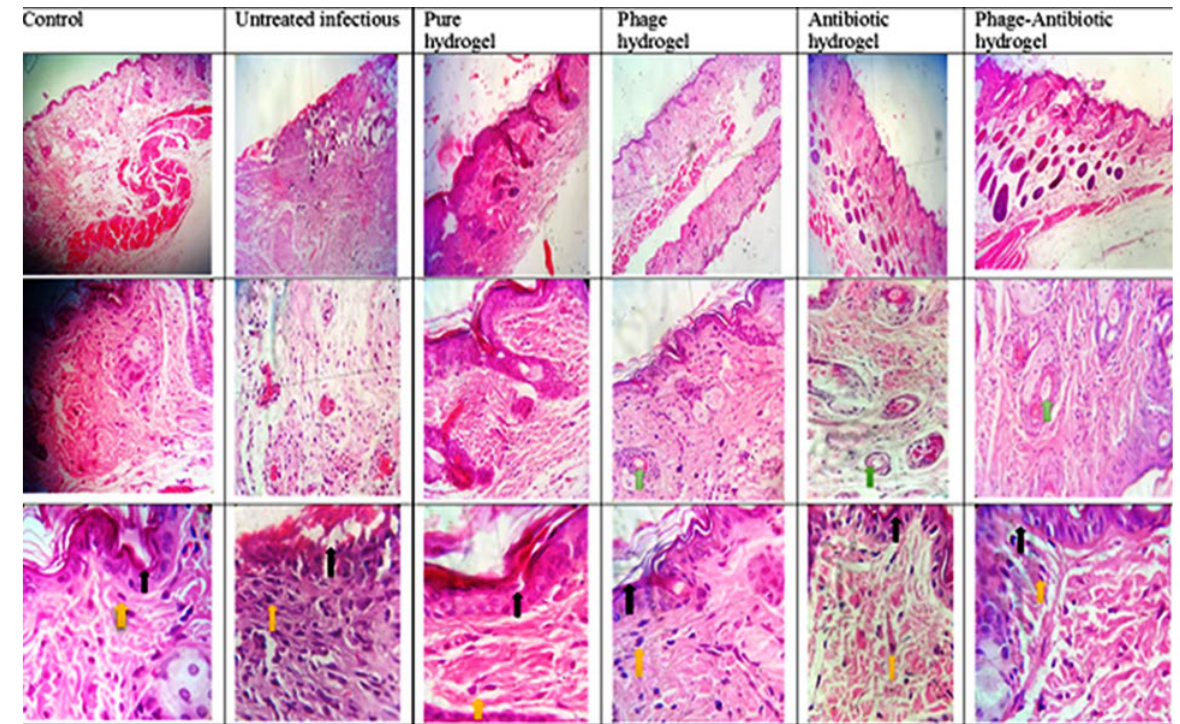
Figure 15. Histopathological sections of the skin in different groups. The black arrows show the repaired epidermis, the yellow arrows the macrophages and the green arrows the hair follicles.